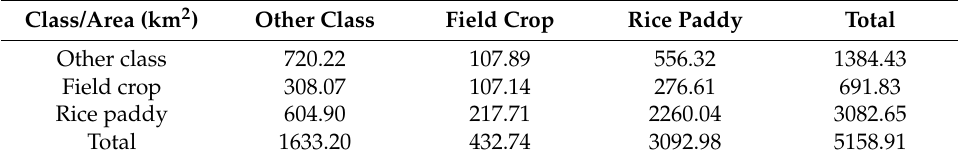
Table 12. Confusion matrix of the OLWDTW method in test site